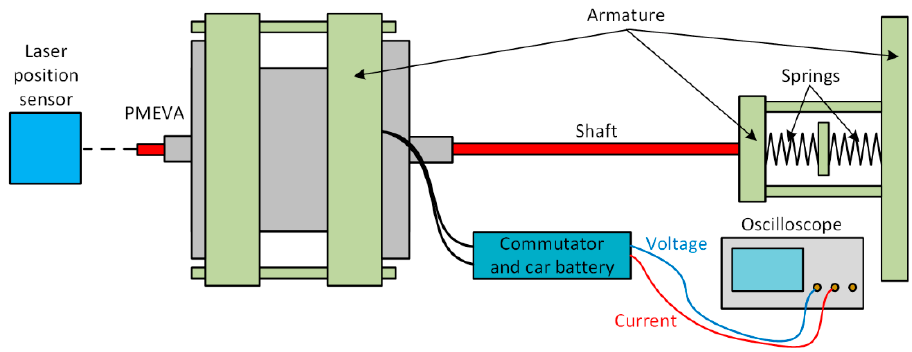
Figure 3. Outline of the measurement stand.